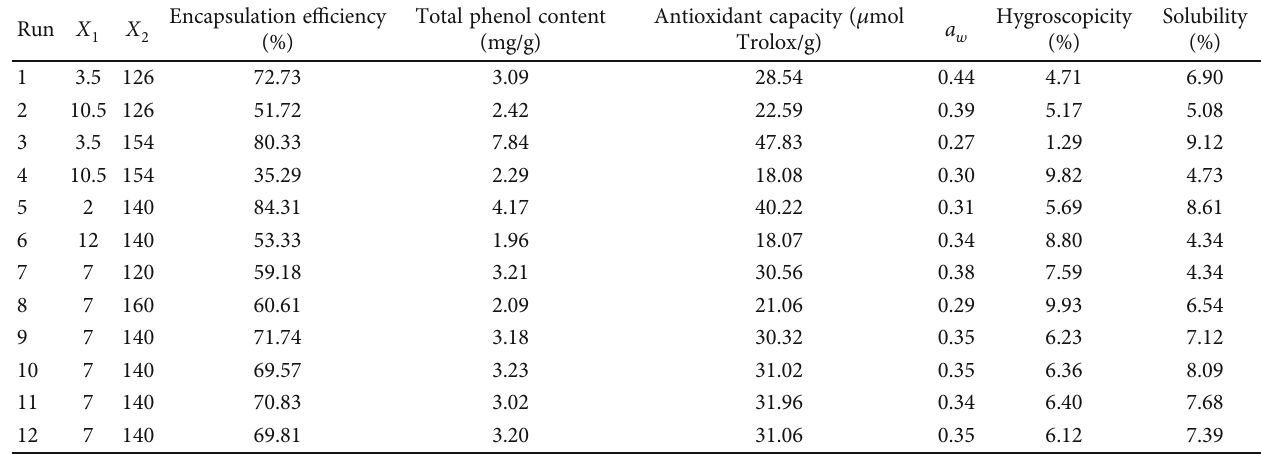
Data show the mean ± standarddeviation . Data with di ff erent letters in the same column indicate a signi fi cant di ff erence ( p < 0 : 05 ). The spray drying process was performed at 140 ° C IDT and 4% starch. Table 2: Result of the response variables of the atomised